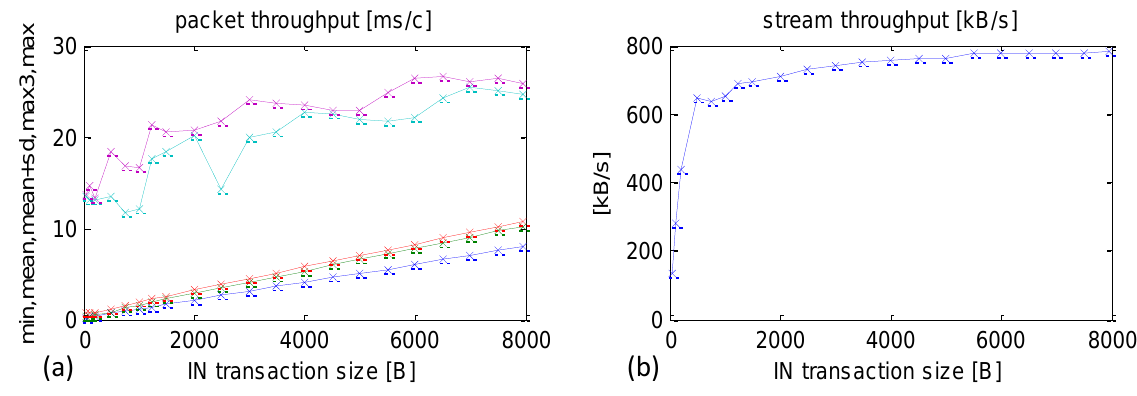
Figure 12. Experimental results after optimisation. Maximum priority set using Android OS functions. ( a ) min, mean, mean + SD, max3, max CCLT depending on packet size. ( b ) Sensors datastream depending on packet